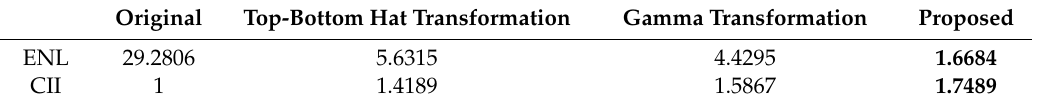
Table 1. Comparison of enhancement effects using different methods.